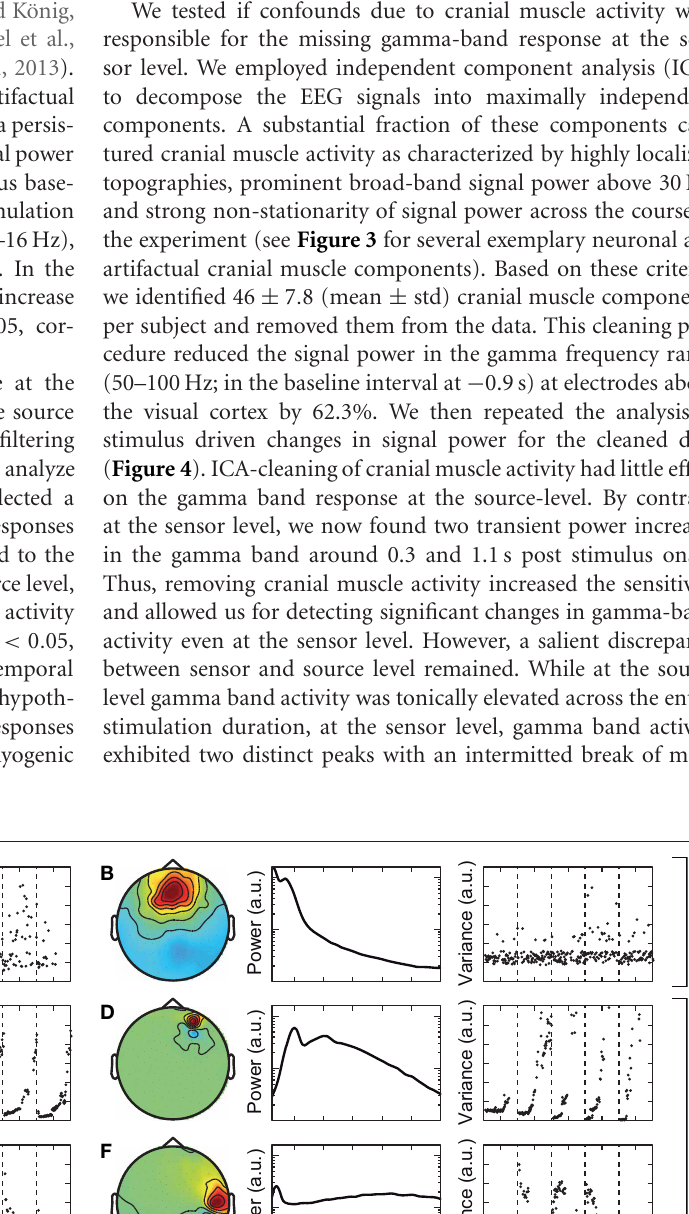
FIGURE 3 | Exemplary independent components (ICs) that capture neuronal (A,B), and cranial muscle activity (C–H). Left: scalp topography of the IC. Center: power spectrum of the IC. Right: